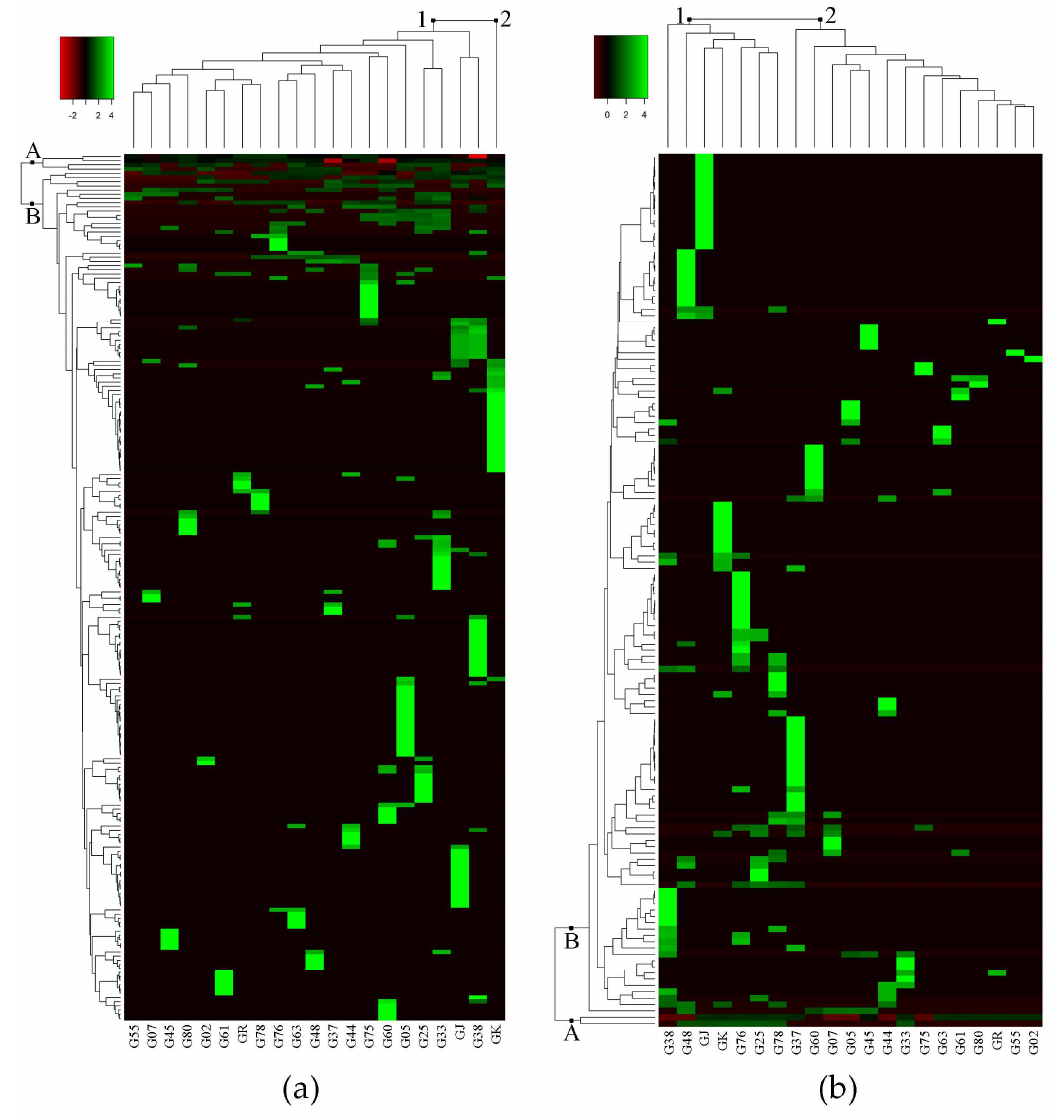
Figure 1. Heat map result of hierarchical group analysis based on metabolite peaks identified from LC-MS and GC-MS analyses. ( a ) heat map of 207 metabolite peaks from GC-MS analysis; ( b ) heat map of 136 metabolite peaks from LC-MS analysis. A = metabolites found in many eggplant accessions; B = metabolites found in a few, or only one, eggplant accession. The green, black, and red bars represent the value of area pct. that has been transformed by log2. The bright green color shows higher peak areas of metabolite, while black and red colors show lower peak areas of metabolites. This coloring is metabolite-wise.